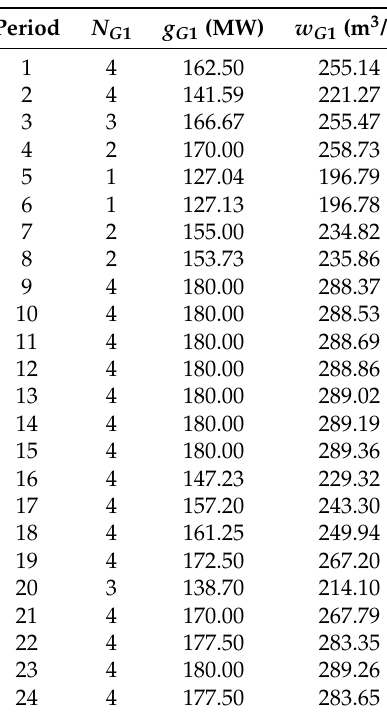
Table 10. Results with water outflow-based objective function-scenario 1.